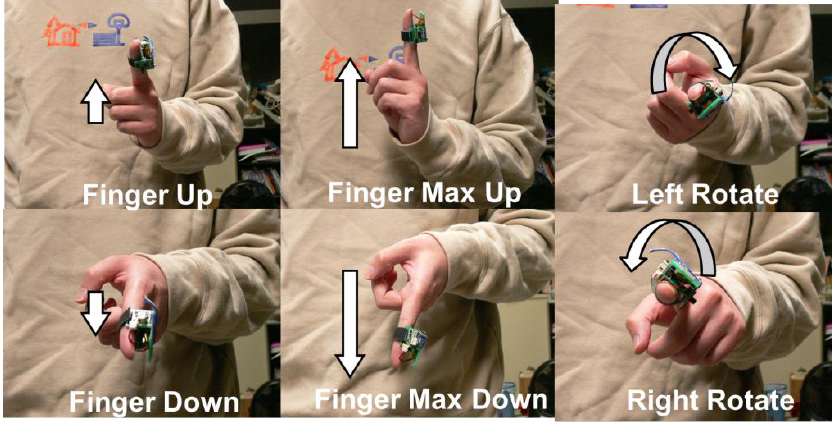
Figure 5. Name and trajectory of the six